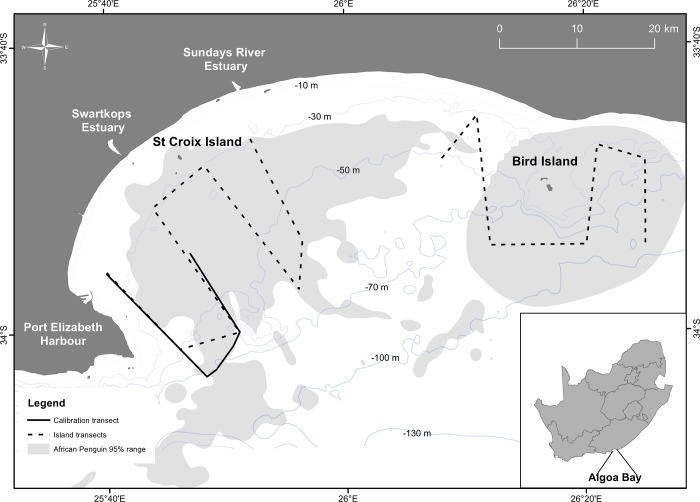
Map of study area showing regular pelagic survey transect routes (dashed lines) around the African Penguin colonies on Bird and St Croix islands and calibration survey route (solid line).Shaded areas denote the 95% kernel density foraging range of African Penguins provisioning small chicks on St Croix and Bird islands between 2008 and 2011 (extracted from [20]).